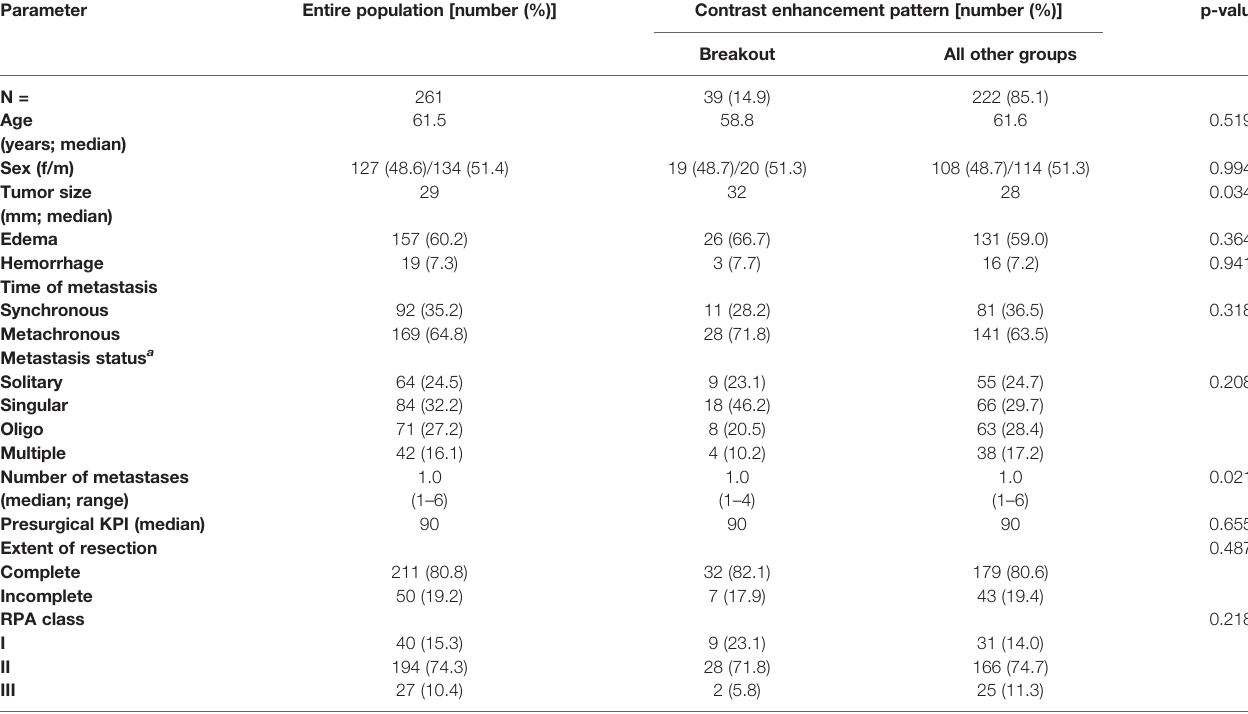
TABLE 3 | Clinical characteristics of the entire patient cohort strati fi ed according to the breakout pattern and all other groups. Parameter Entire population [number (%)]